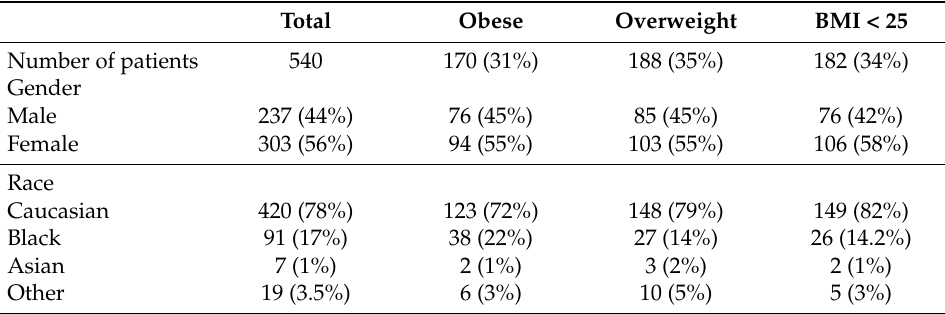
Table 2. Comorbidities among patients ( n = 540).